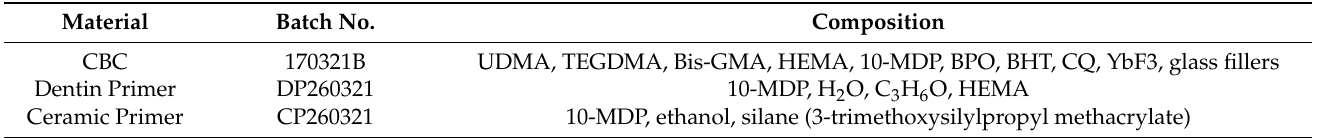
Table 1. Compositions of the materials used in this study. Fluorographene was added to these ma- terials after micronization (CBC 2% FGm) and exfoliation (CBC 2% FGm, DP 2% FG, and CP 2%